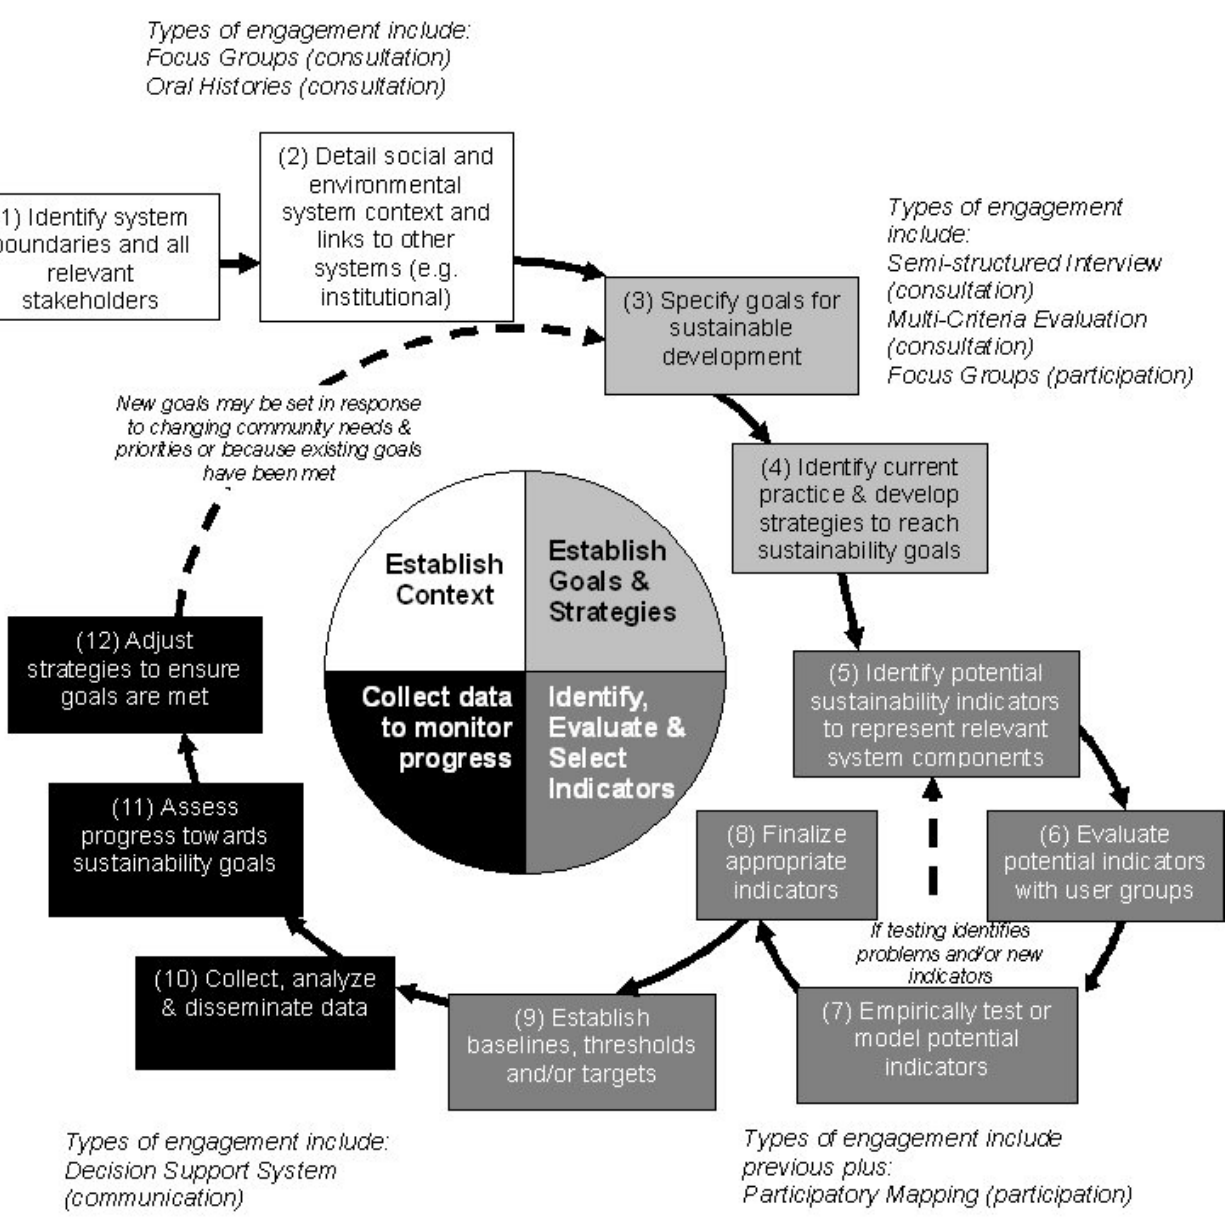
Fig. 2. Learning process for environmental sustainability assessment using indicators based on local and scientific knowledge. (Adapted from Reed et al. 2006; methods used in this case study are shown in italics around the outside of the figure, showing the type of engagement according to Rowe and Frewer’s (2005)